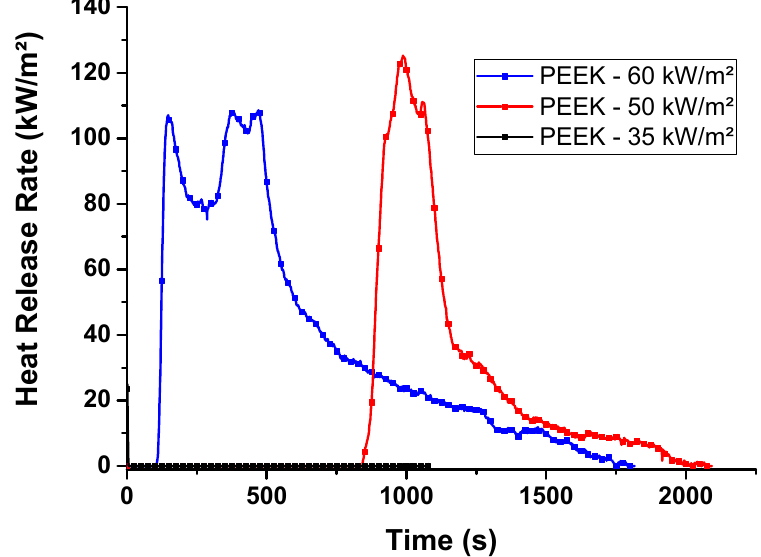
Figure 9. HRR profile of PEEK samples subjected to an incident heat flux of 50 kW / m 2 using the MLC. Sample dimensions: (100 × 100 × 3.7) mm 3 . Distance from the heating cone: 35 mm.